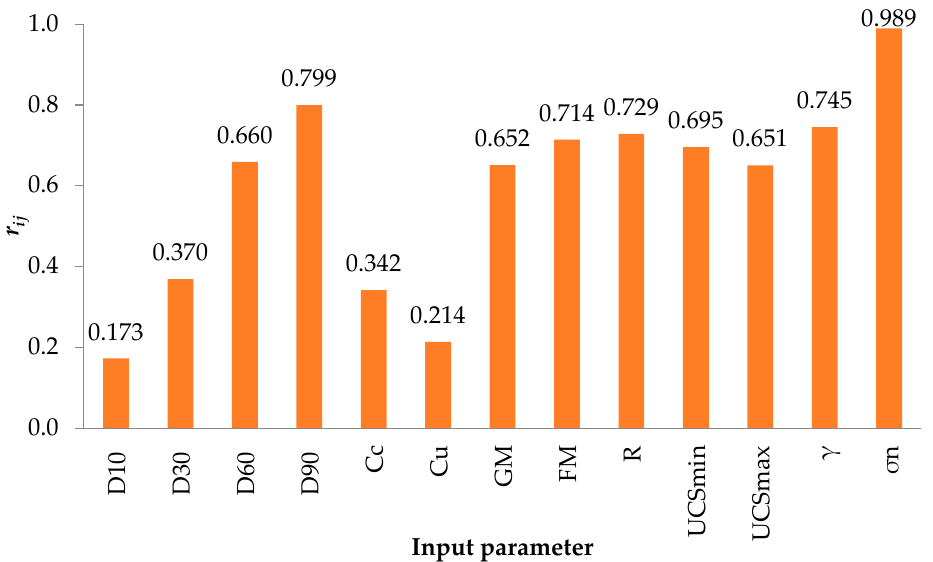
Figure 4. Sensitivity analysis of the input parameter.